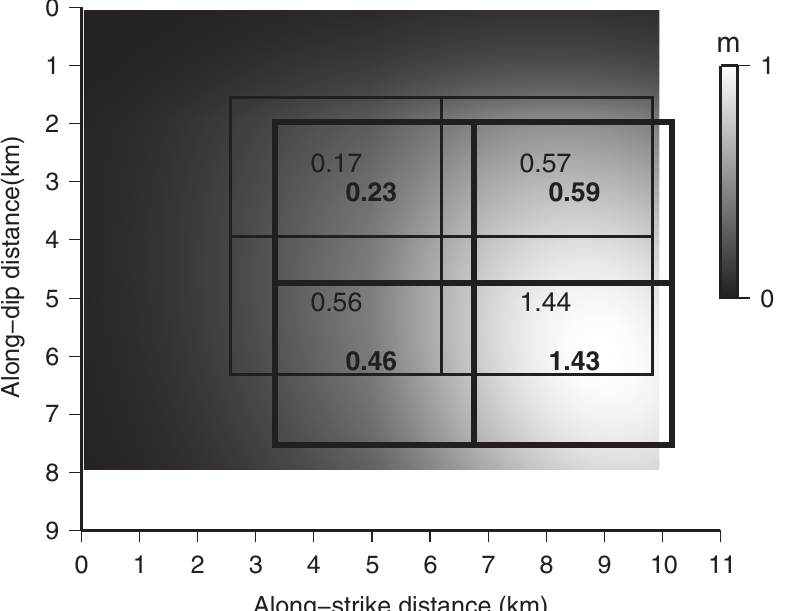
Fig. 7. Best fit 2 × 2 fault in the HHS (thin-line rectangles) and LHS (thick-line rectangles) over the distrib- uted-slip source fault. Numbers give